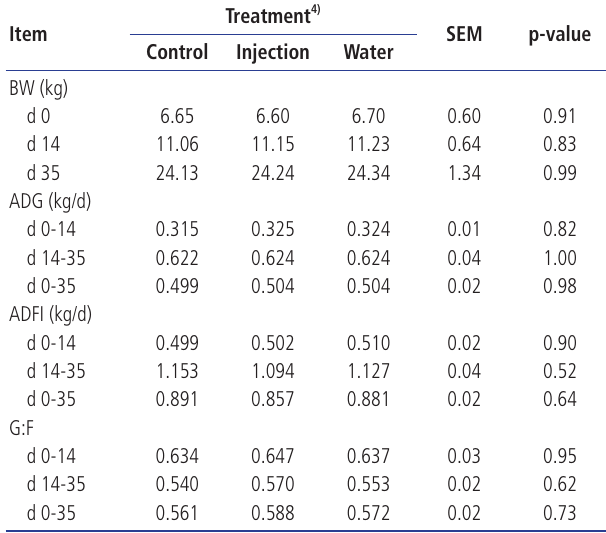
Table 1. Growth performance of pigs administered with vitamin D drinking water under ovalbumin challenge (experiment 1)